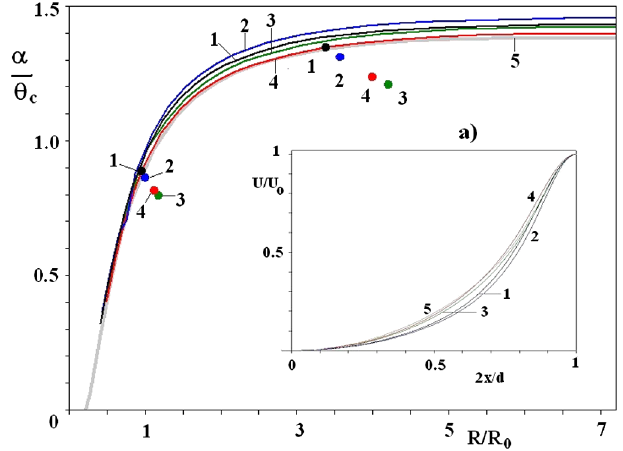
FIG. 1. The calculated universal Ξ ð R=R 0 Þ ¼ h α i = θ c -functions for positively charged particles and for normalized potentials for (110) plane of germanium which were shown in insert (a). The calculations were done for the Hartree-Fock potential at T D ¼ 290 ° K and at T ¼ 360 ° K (the curves 1 and 2, correspond- D ingly) and for the Moliere potential at T D ¼ 360 ° K and at T D ¼ 285 ° K (the curves 3 and 4, correspondingly). All the curves are functions of generalized variable κ ¼ R=R 0 , The small circles are the experimental data [9] presented for corresponding values of generalized variables Ξ and κ . The table I contains the necessary (for such presentation) quantities θ c and U 0 . The experimental errors are less than (cid:3) 0 . 02 (for Ξ -variable). The curve number 5 [in insert (a)] corresponds to (110) plane of silicon and it is presented for